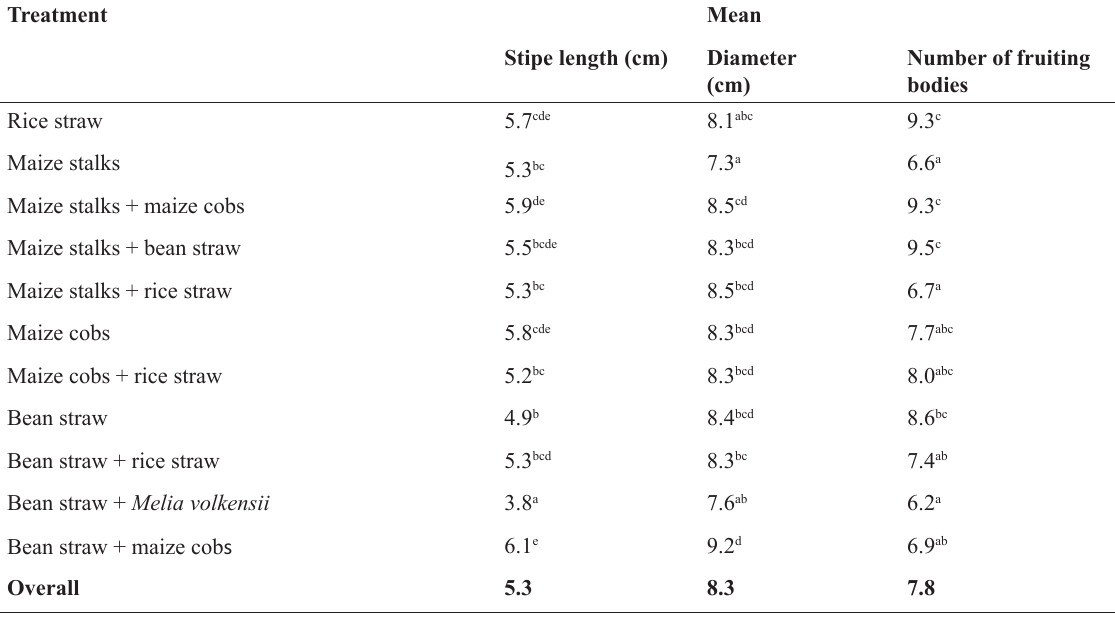
Table 3 Stipe length, diameter and number of fruiting bodies in function of substrate composition